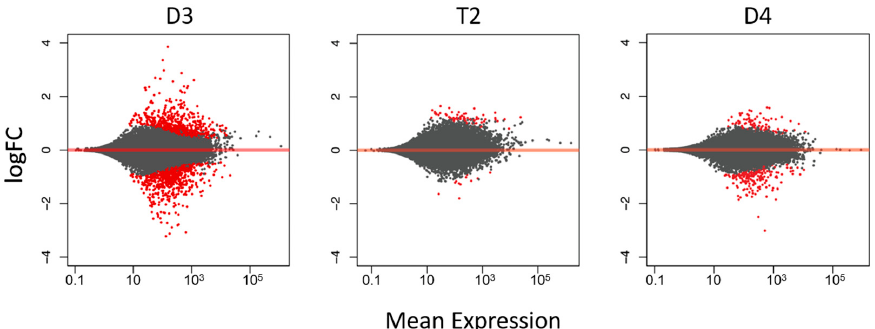
Figure 3. Pairwise comparisons of differential gene expression, showing average log fold-change (FC) in expression between inoculated and control samples relative to mean expression (mean of normalized counts of all samples) for species D3, D4 and T2. Red dots are genes that were significantly differentially expressed (false discovery rate (FDR) < 0.05), while gray dots indicate genes that were not significantly differentially expressed.